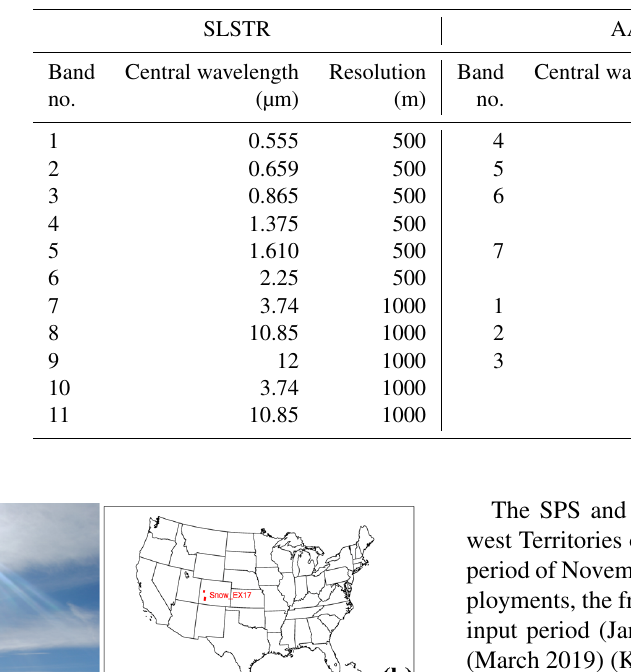
Table 1. Instrument characteristics of AATSR and SLSTR.